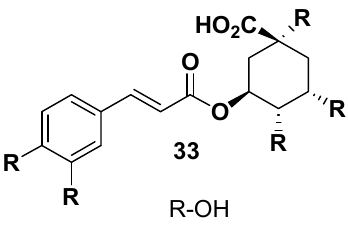
Figure 6. Chemical structure of chlorogenic acid ( 33 ) [26].